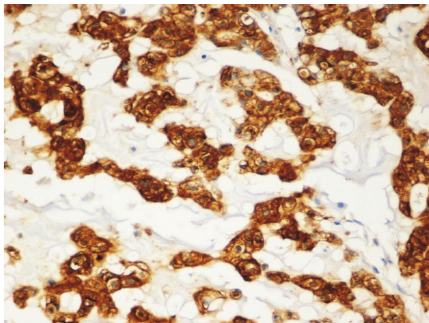
Figure 4: Positivity of the tumor cells for vimentin (40x).